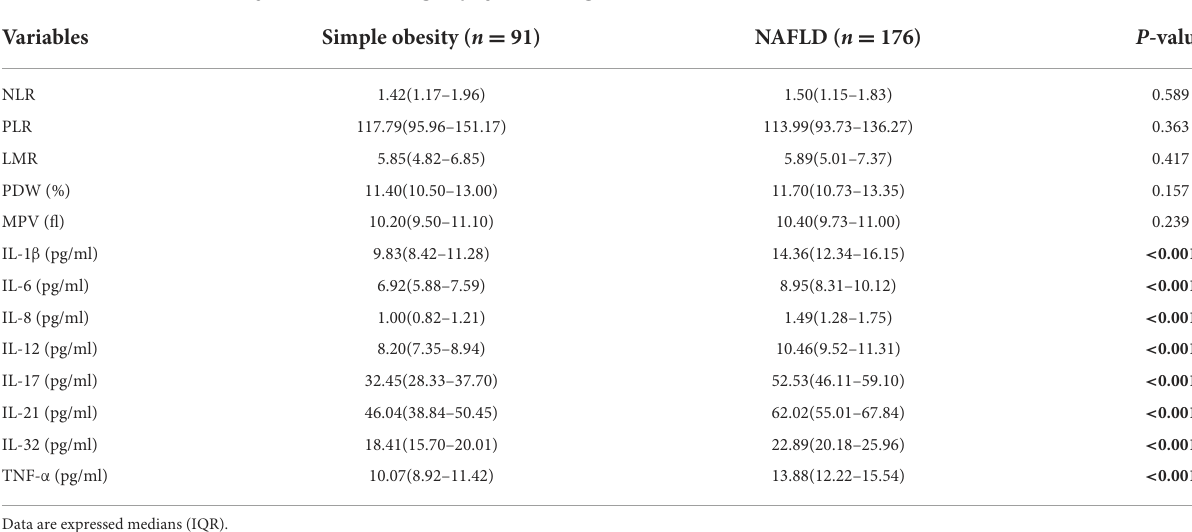
TABLE 2 Levels of inflammatory markers of the subgroup by NAFLD diagnosis.